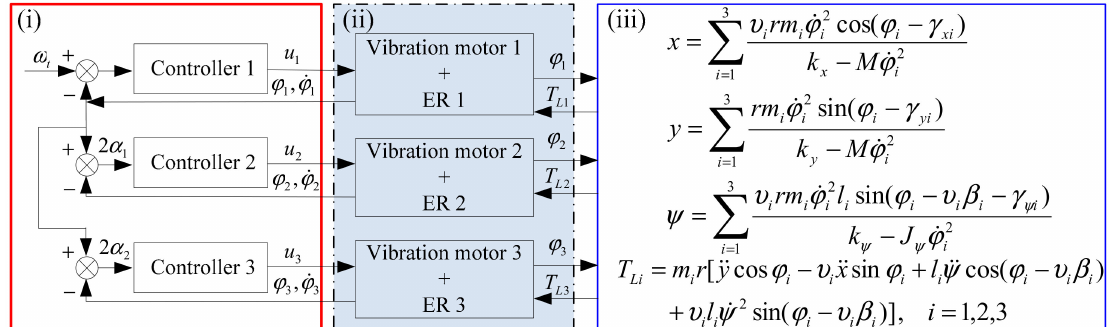
Figure 2. Electromechanical coupling of the vibration system driven by three